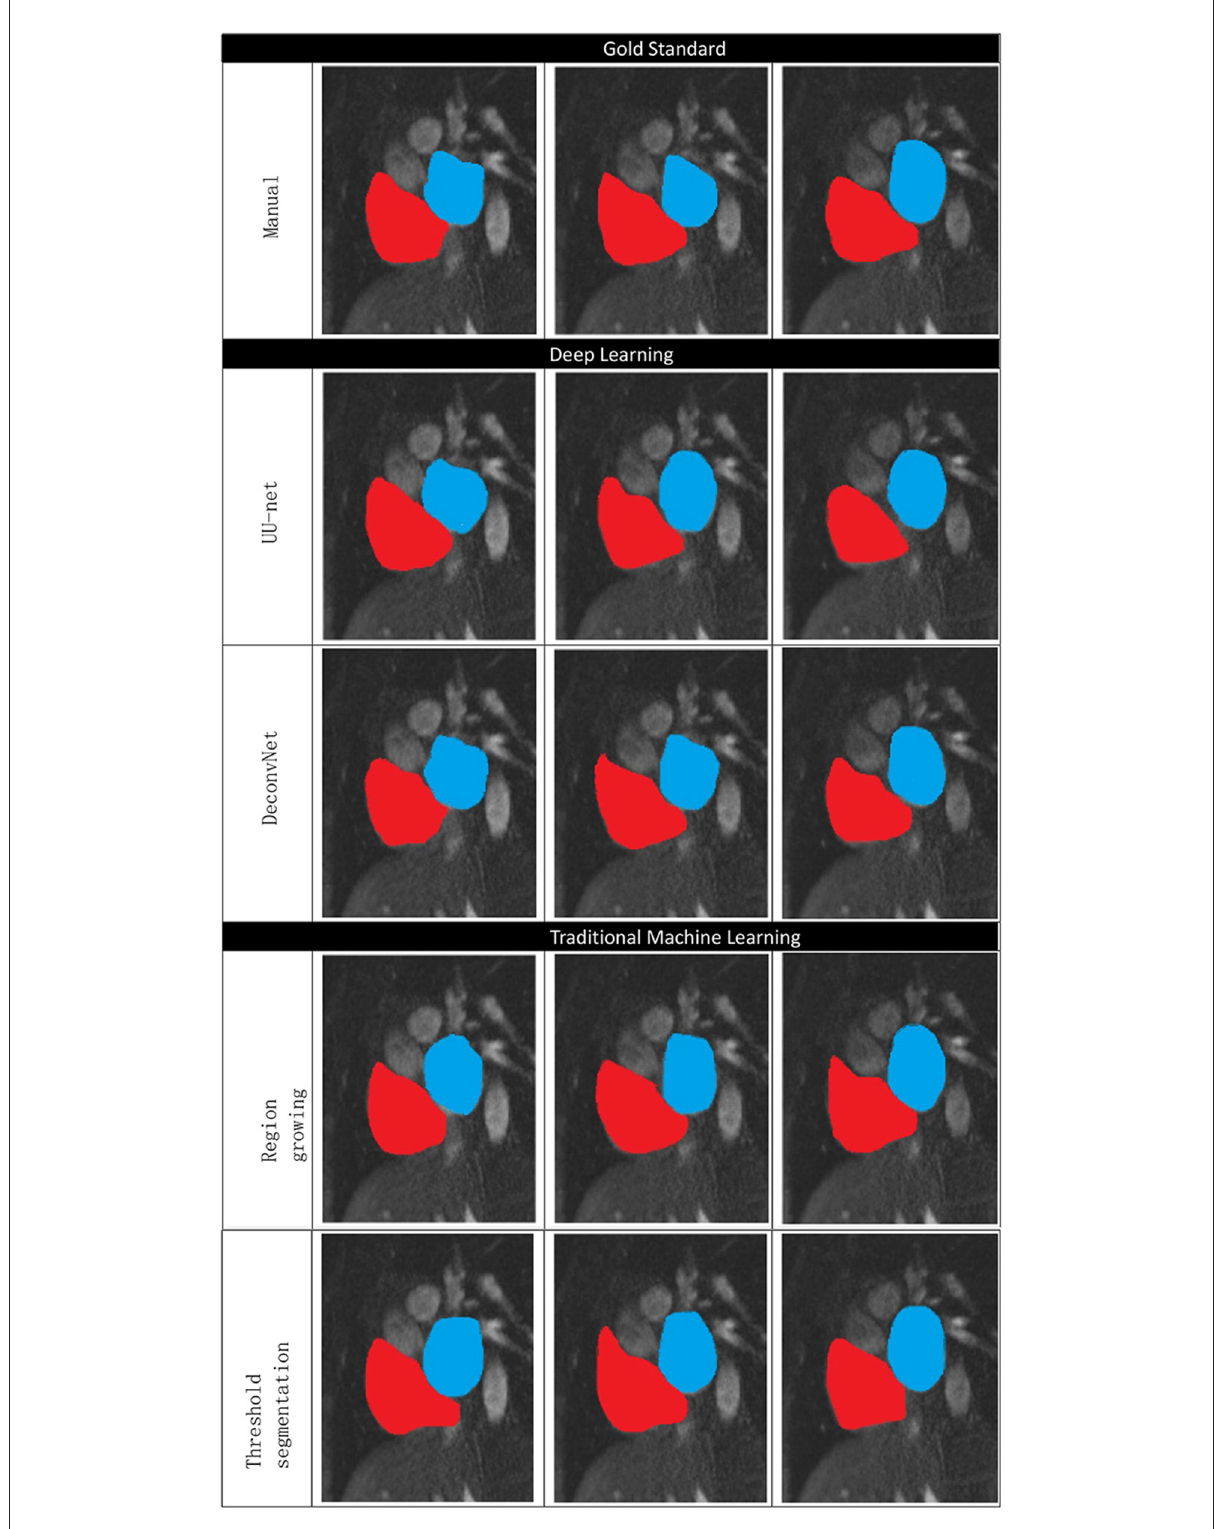
FIGURE10 Comparison of traditional methods, deep learning, and manual segmentation in atrial